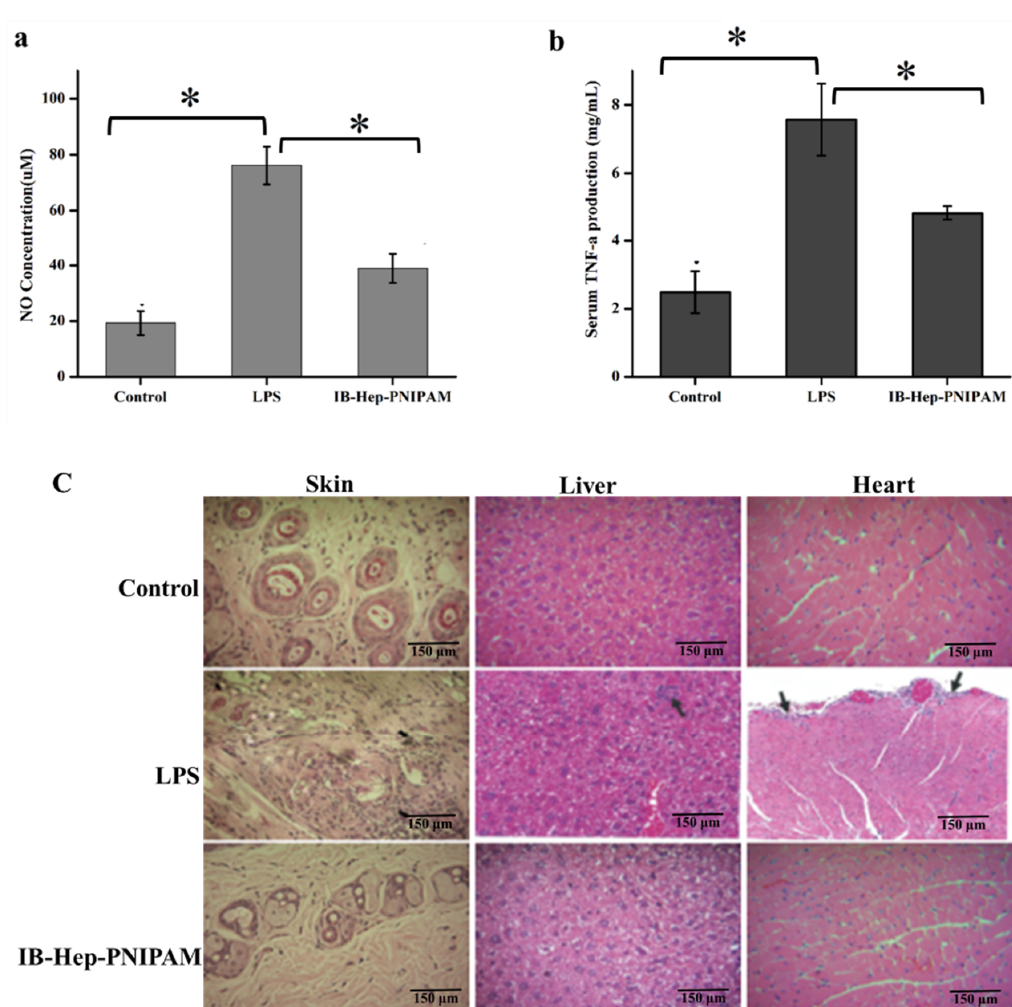
Figure 8. Effects of IB-Hep-PNIPAM on LPS-induced ( a ) NO and ( b ) TNF-α production. Data are presented as means ± SD for three independent experiments. * p < 0.05 compared with the untreated LPS group. ( c ) Histological observations of wounded skin, liver, and heart tissues stained with H&E. Bars = 150 μm. The arrows show the infiltration of inflammatory cells.